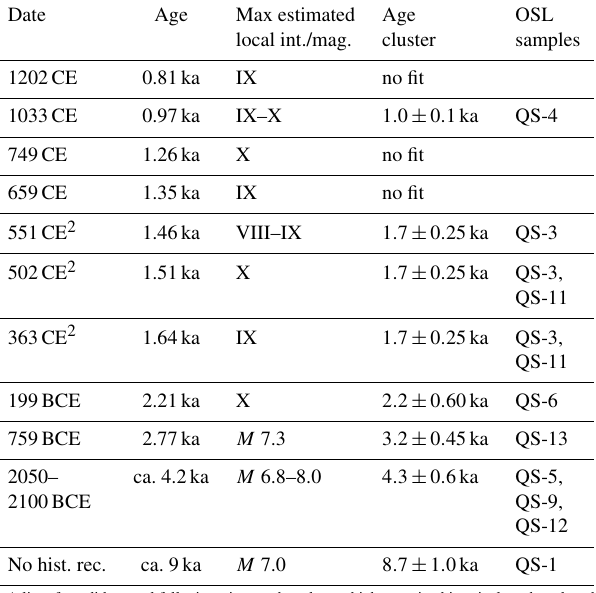
Table 4. Selected historic earthquakes, candidates as possible